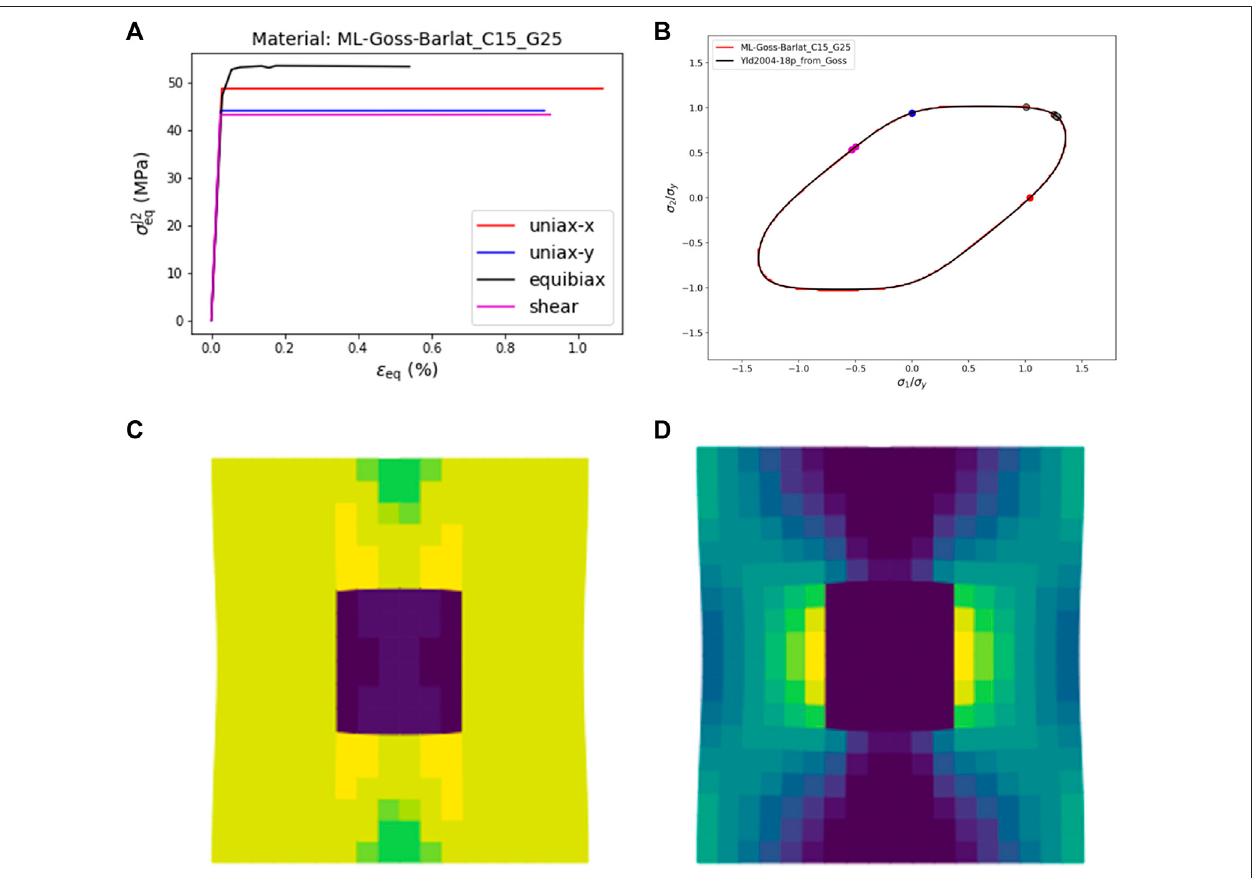
FIGURE 18 | (A) Equivalent J2 stress vs. equivalent total strain curves obtained for elastic-ideal plastic material behavior under the loading conditions speci fi ed in the legend for the rained ML yield function; (B) yield loci of ML and Barlat-type materials and the fl ow stresses obtained from the load cases in (A) plotted as principal stresses; (C) equivalent J2 stress; and (D) equivalent plastic strain resulting from the 2D plane strain model with a square-shaped elastic inclusion in the